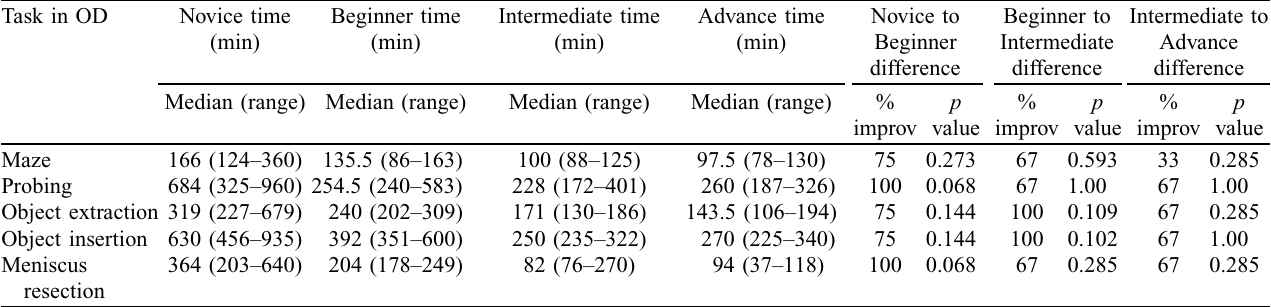
Table 4. Difference in performance under the opaque dome (OD) as measured by percent improvement between subsequent groups with higher level of expertise of